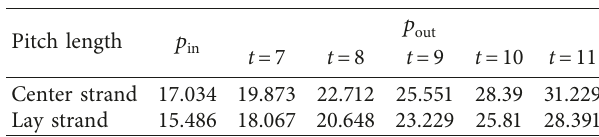
Table 4: The geometric dimensions of the single wire strands with different pitch length (mm).